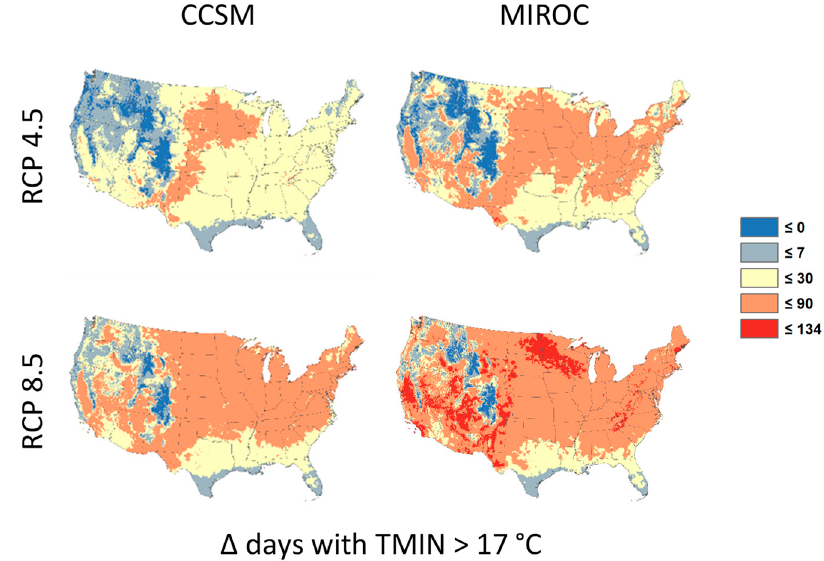
Figure 5. Representative maps of CCSM and MIROC climate change projections under RCP4.5 and RCP8.5 emissions scenarios. Colors denote the change in the average annualized number of warm season days where the minimum temperature exceeds 17° Celsius for the period 2085 to 2095 using 1995 to 2005 as the baseline period.